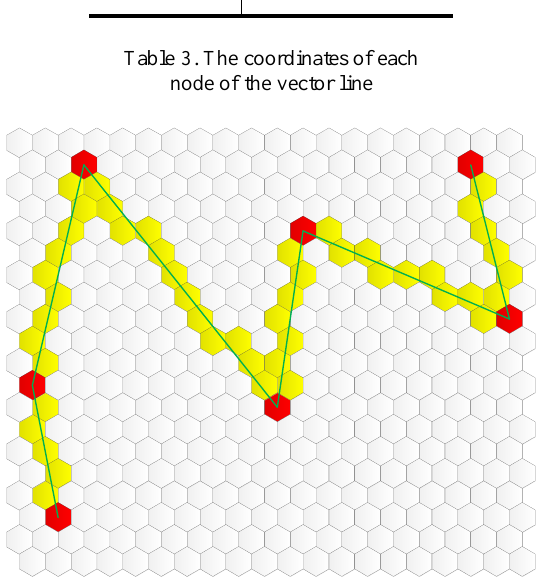
Figure 6. The generated vector line in the hexagon grid